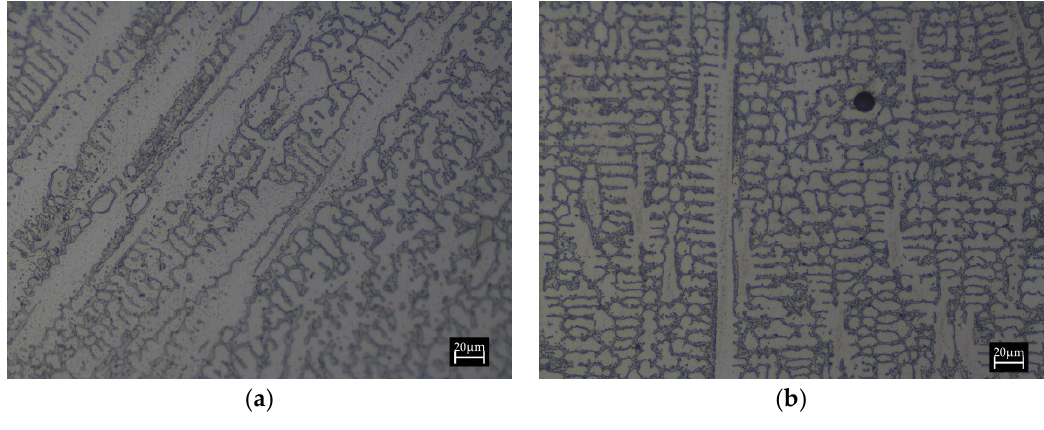
Figure 8. Dendritic images of Sample 5 ( a ) and Sample 6 ( b ).